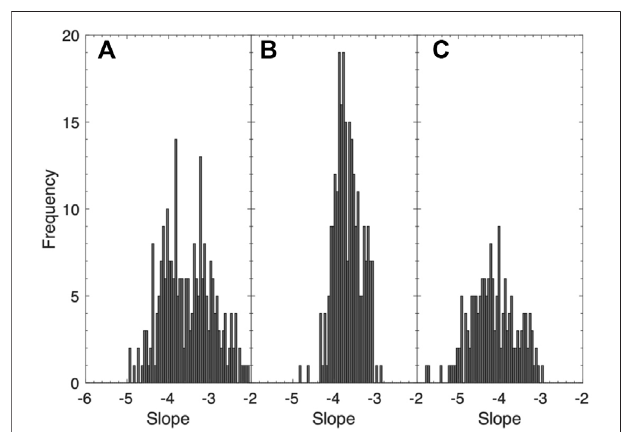
FIGURE 8 | Submicron particle size distribution (PSD) measured by ViewSizer 3000 in the NPO-18 and NAO-21 sites (left y-axis) and their ratio (right y-axis).